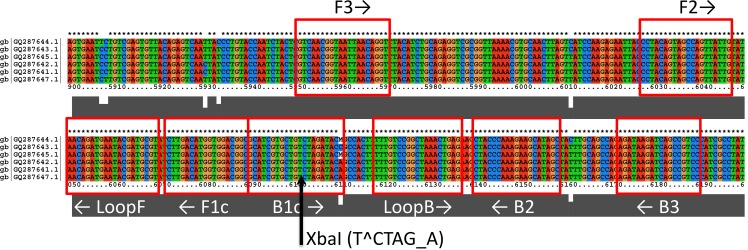
Sequence alignment showing priming regions for the WEEV nsP4 primer set.The arrow indicates the location of the XbaI restriction site. Genbank accession numbers refer to the following strains: GQ287644.1 = BFS2005; GQ287643.1 = Montana-64; GQ287645.1 = 71V1658; GQ287642.1 = Kern; GQ287641.1 = Imperial; GQ287647.1 = 85–452NM.